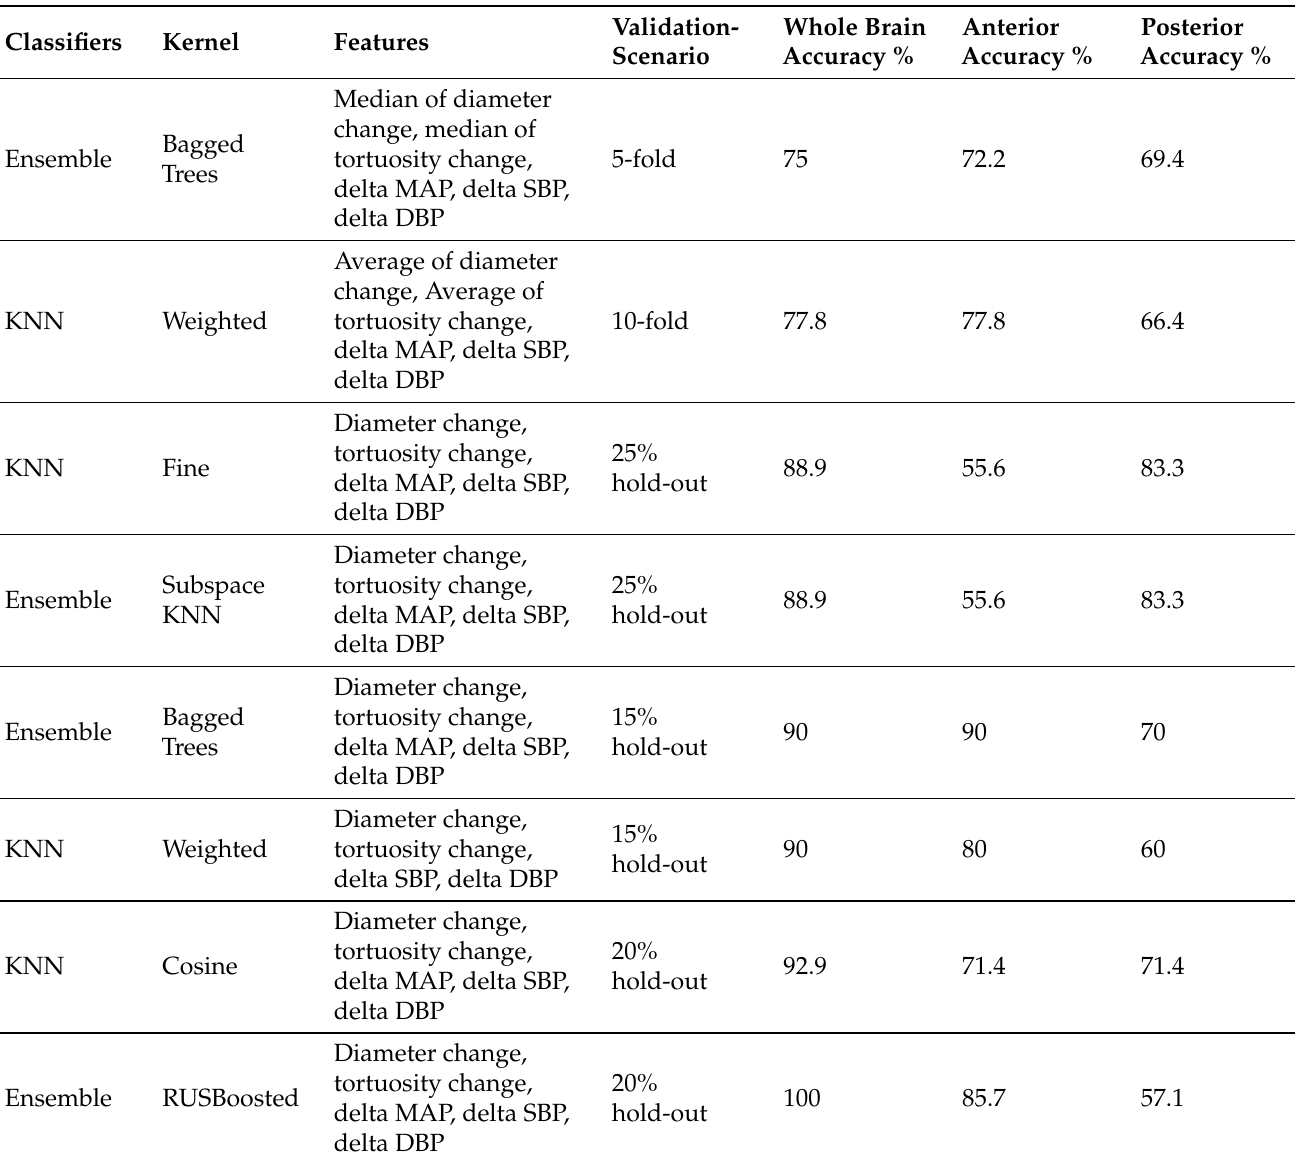
Table 1. Classification Accuracy based on the whole brain, anterior compartment, and posterior